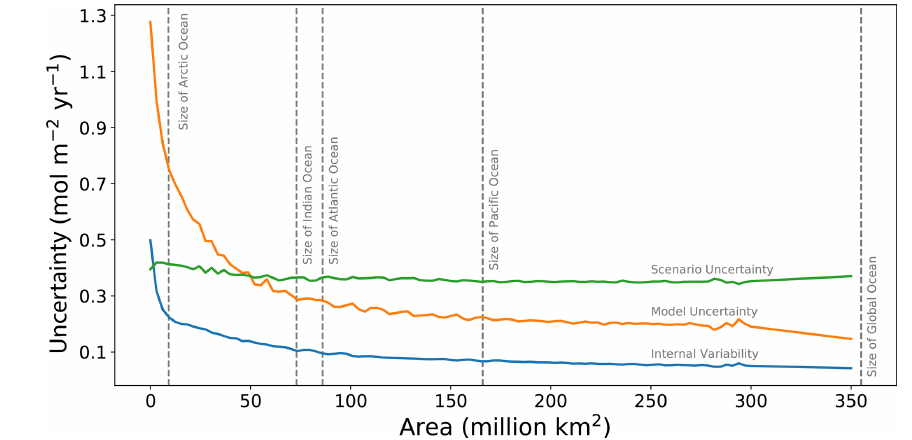
Figure 3. Sources of uncertainty versus area of averaging. Internal variability is based on ssp245 year 2050 of all CanESM5 members. Scenario uncertainty is based on all scenarios of the 13 models at year 2050, and model uncertainty is the corrected standard deviation of our 13 models at year 2050 of ssp245. The values of uncertainties are averaged over all different rectangular areas of each size that can scan the globe. Dashed lines indicate the size of the averaging window and not a specific